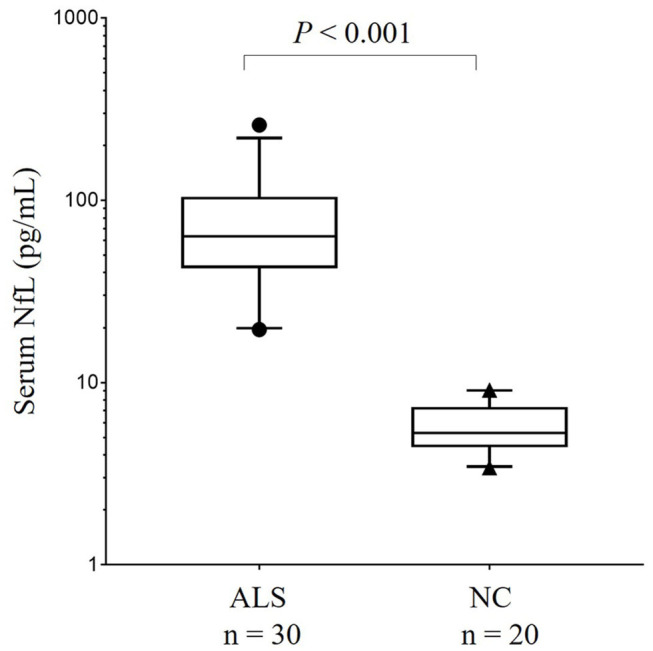
The comparison of serum NFL concentration between patients with ALS and HCs in China. Serum NFL concentration in patients with ALS and HCs. Given are the median concentrations, 25th and 75th percentiles, and 5 and 95% whiskers. Points represent values below 5% percentile and above 95% percentile. ALS, Amyotrophic lateral sclerosis; HCs, Healthy controls; NFL, Neurofilament light chain.